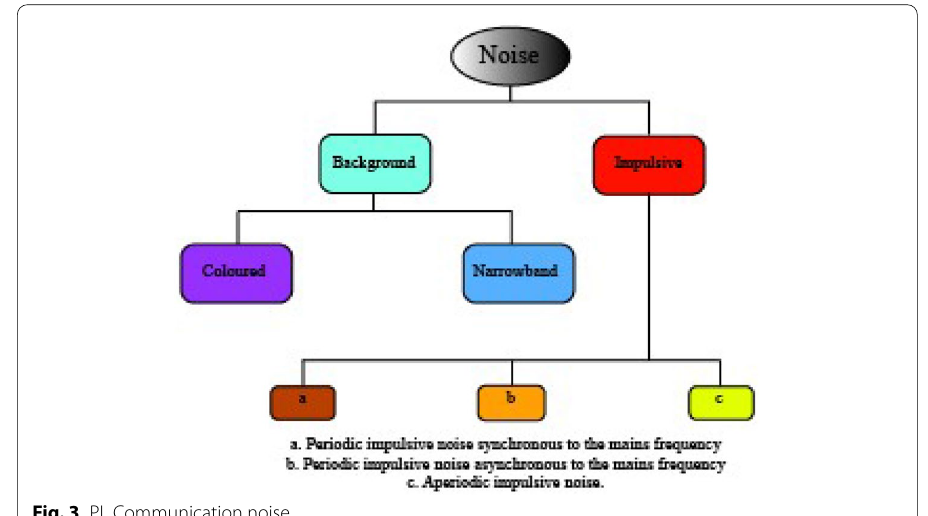
Fig. 3 PL Communication noise